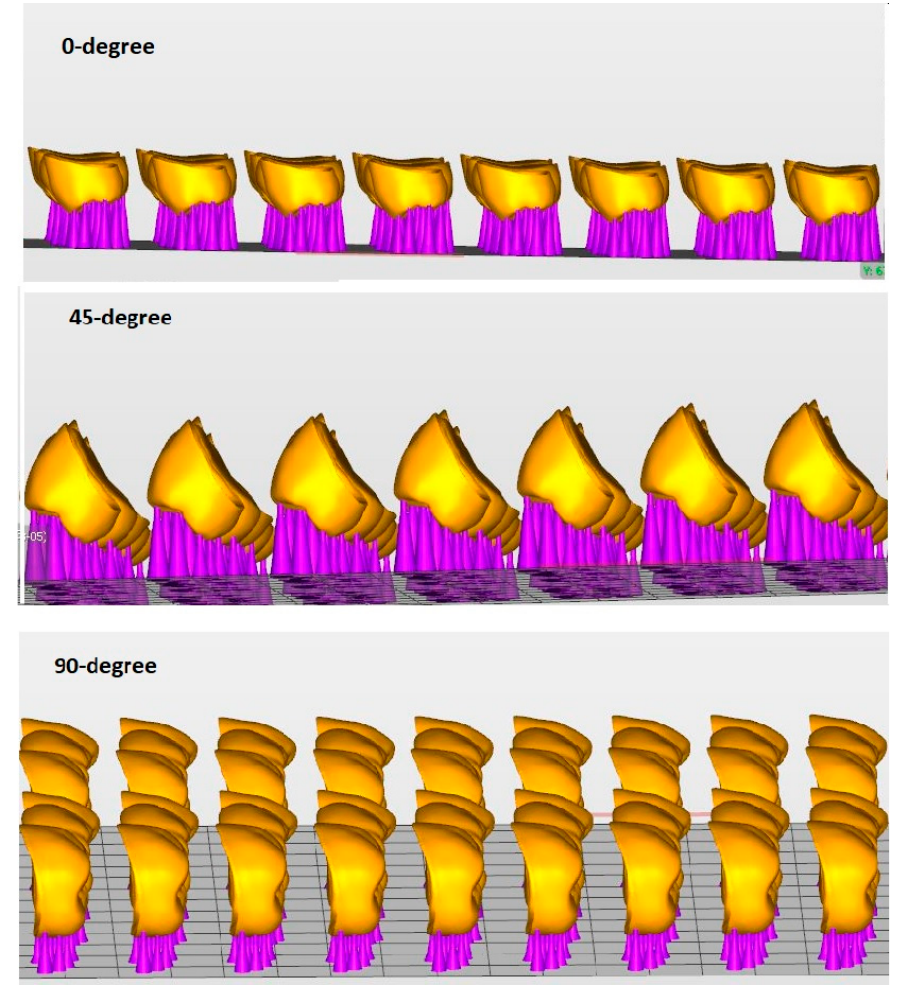
Figure 2. Specimen design with different printing orientations with scale bar 5 mm.